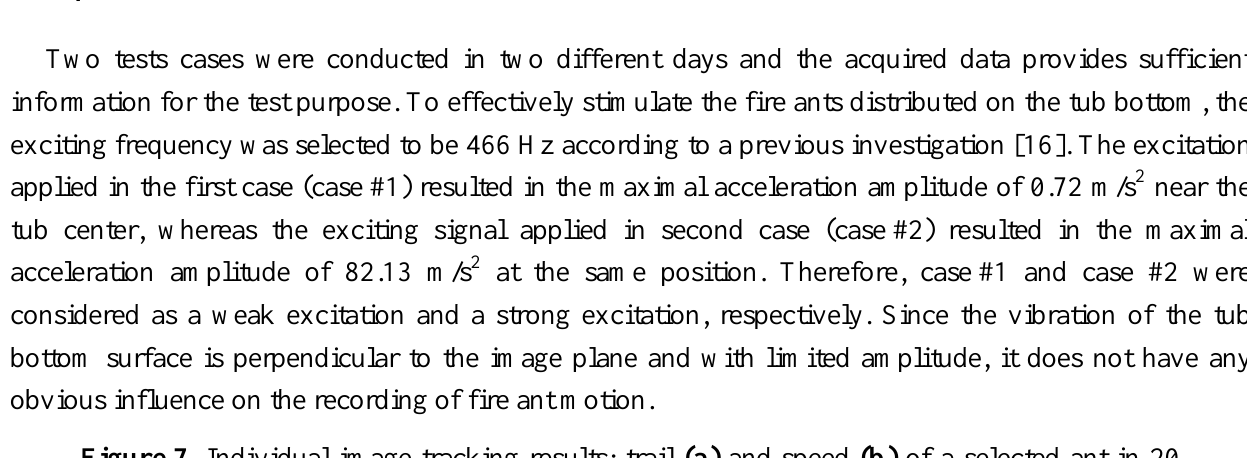
Figure 7. Individual image tracking results: trail (a) and speed (b) of a selected ant in 20